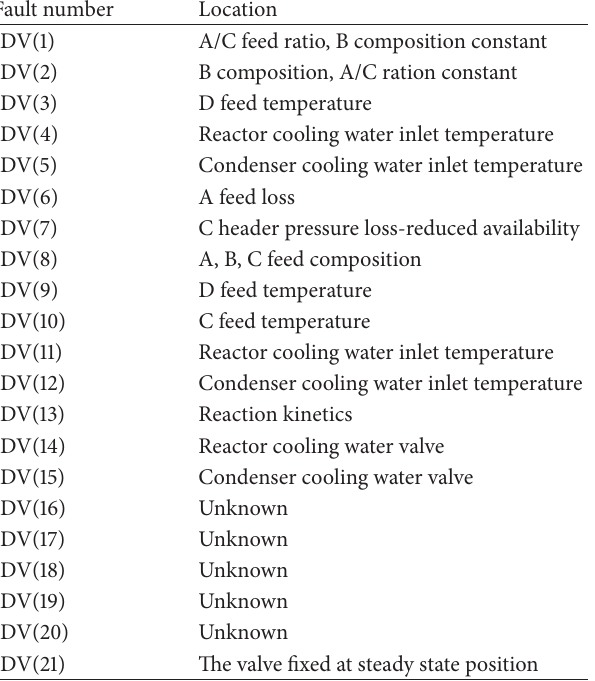
Table 1: Predefined faults in Tennessee Eastman